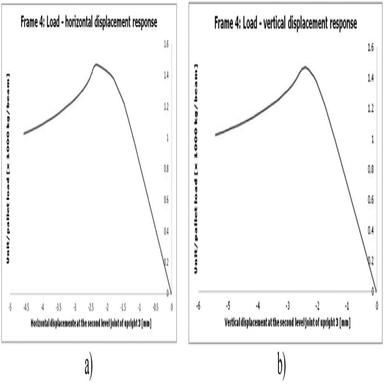
Load-displacement response of SR4: a) load-horizontal displacement and b) load-vertical displacement.